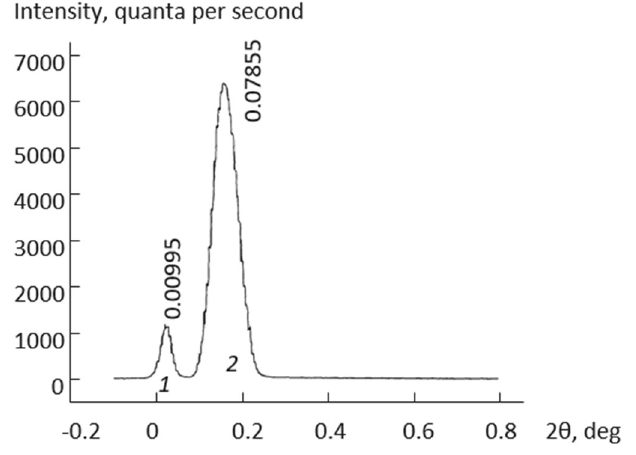
Figure 2. Radiograph of polished polycrystalline tantalum under conditions of total external reflection of X-rays with indication of sliding angles α in degrees above each maximum [18].